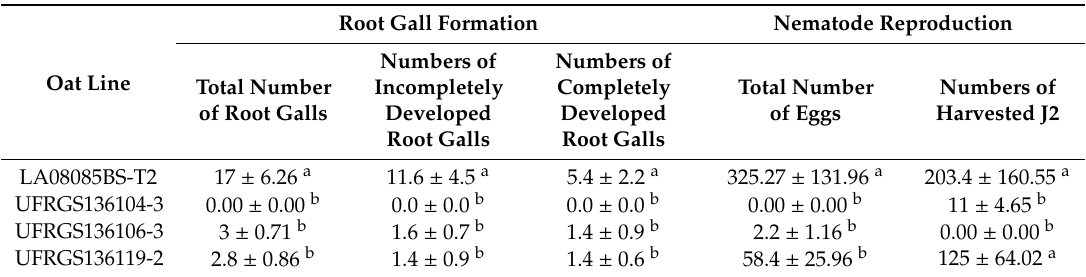
Table 2. Comparison of root gall formation and nematode reproduction of M. graminicola on oat lines at 40 days postinoculation (dpi).